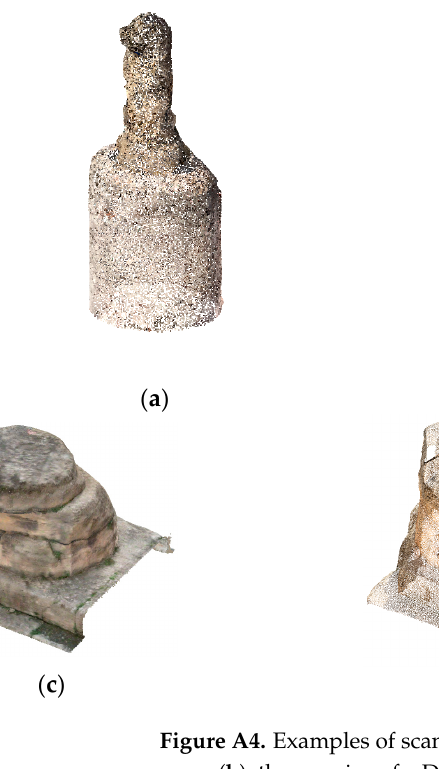
Figure A3. Comparison of mean values of planarity for samples scanned at a distance of 1.5 m.